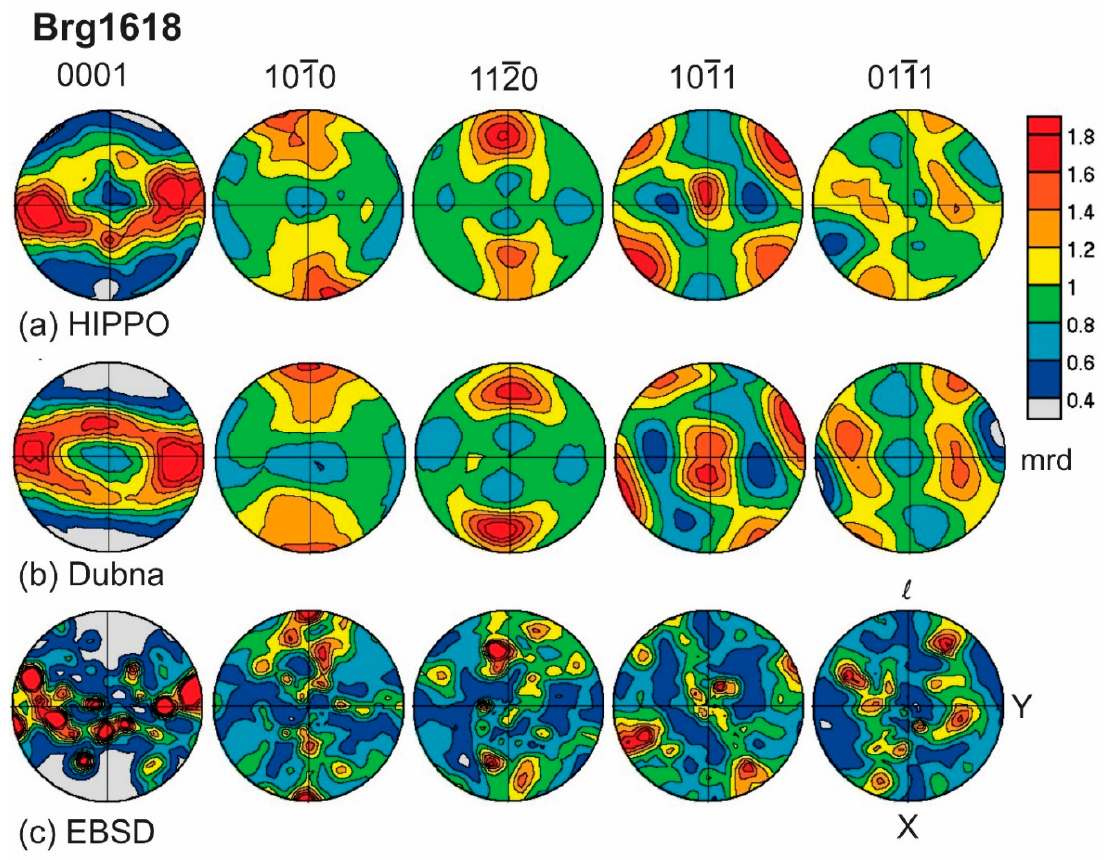
Figure 15. Comparison of neutron and EBSD pole figures for sample Brg1618. ( a ) Neutron diffraction with HIPPO, LAN; ( b ) neutron diffraction with SKAT, JINR-Dubna; and ( c ) EBSD with SEM. Equal area projection.